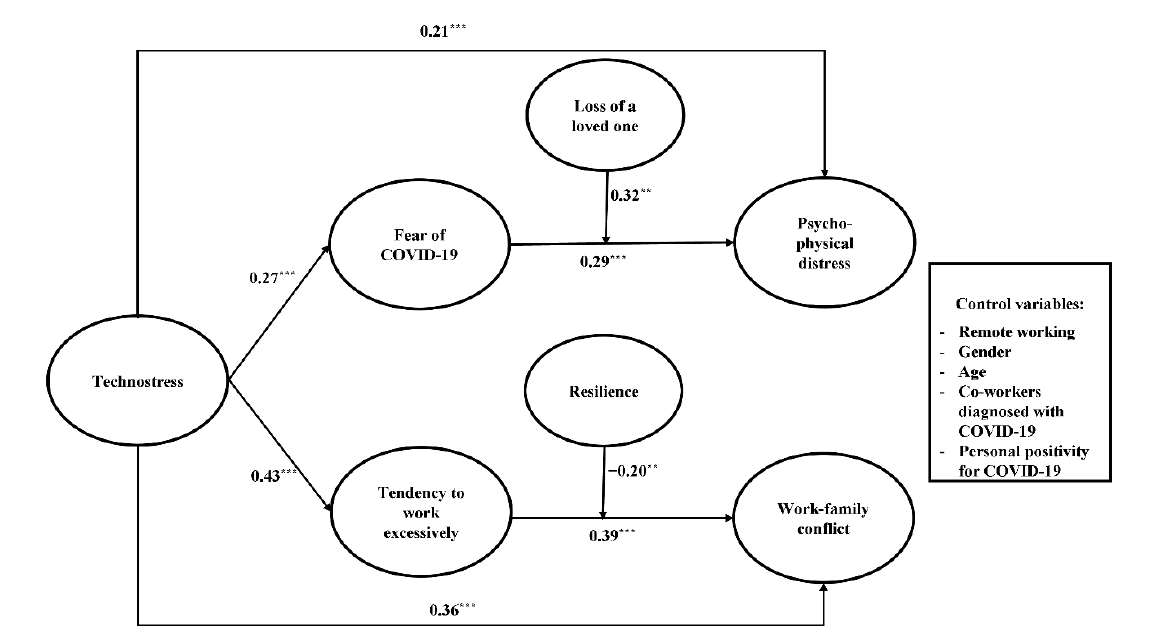
Figure 2. Path coefficients of the hypothesized model . ** p < 0.01; *** p < 0.001. Table 4. Path coefficients and conditional effects for the moderated mediation model.